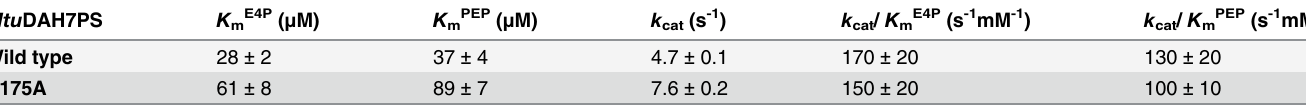
Table 2. Kinetic parameters determined from the Michaelis-Menten kinetics of Mtu DAH7PS N175A